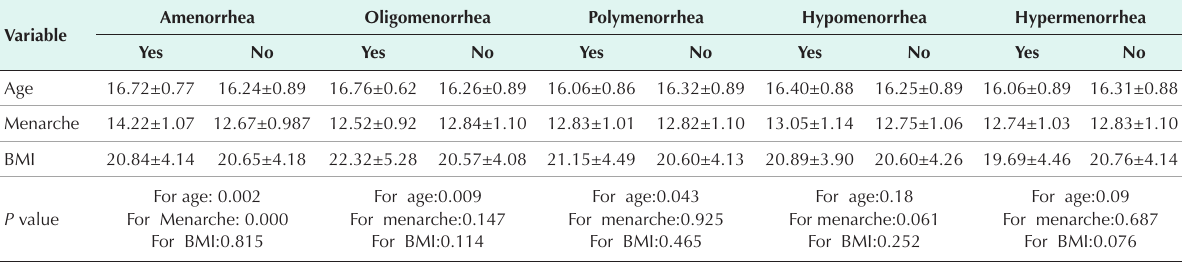
Table 3. Relationship Between Menstrual Disorders with Variables of Age, Age of Menarche, and BMI